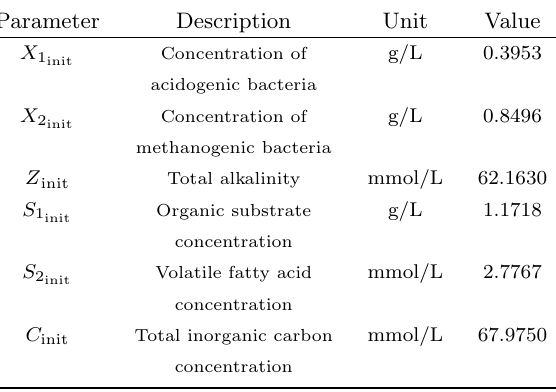
Table 2: Initial state in the AM2 model Parameter